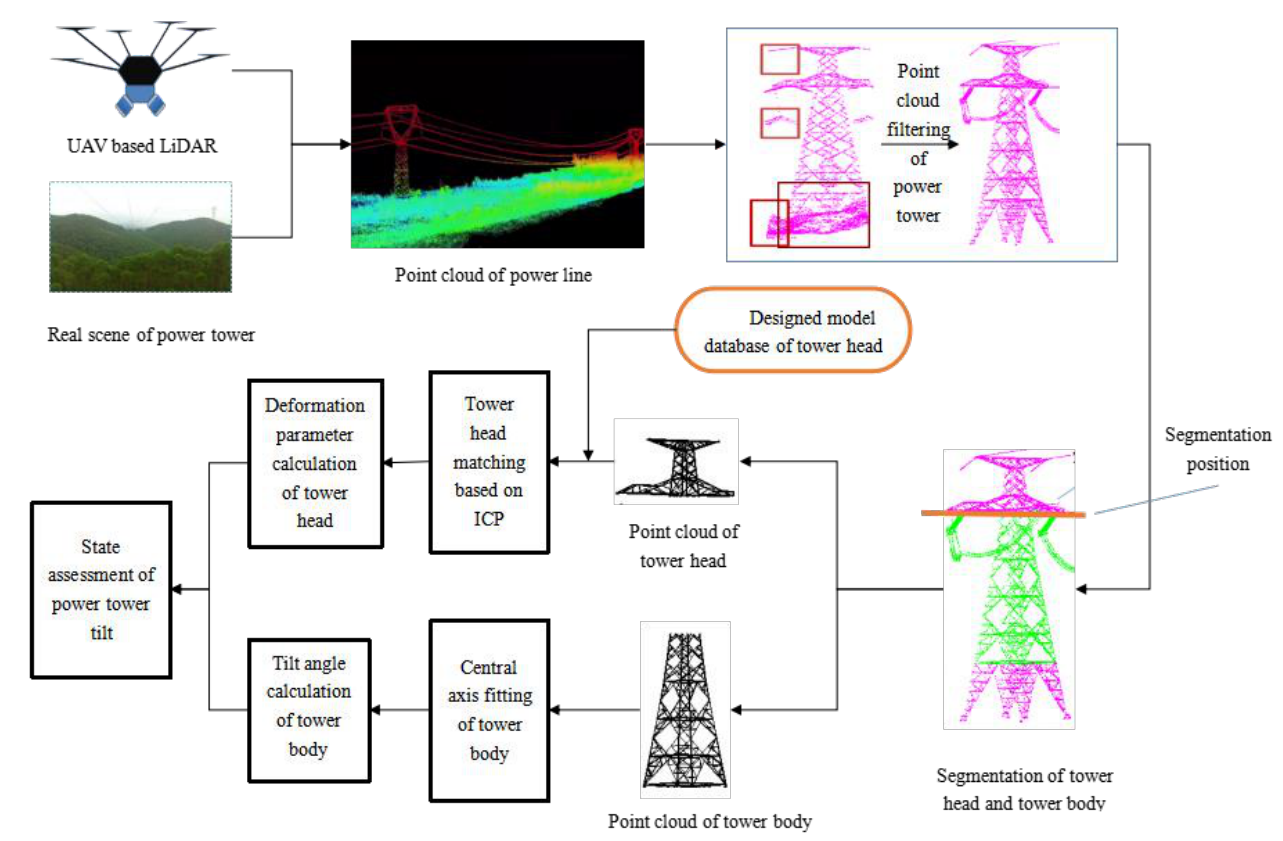
Figure 2. Flow chart of the proposed